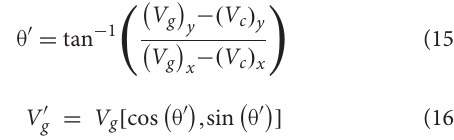
Frontiers in Marine Science |